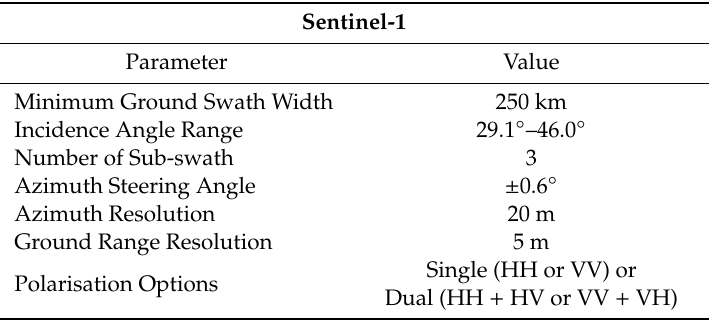
Table 1. Characteristics of the Sentinel-1 (Interferometric Wide Swath (IW)), sensor.